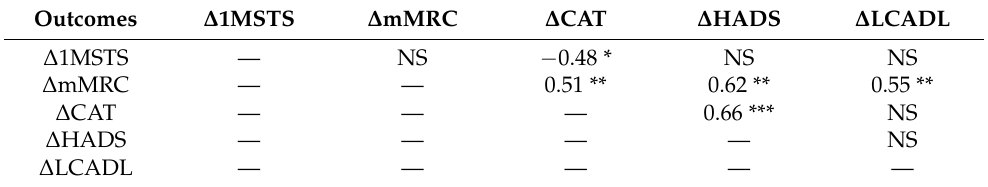
Table 3. Correlations between changes in outcomes after home-based pulmonary